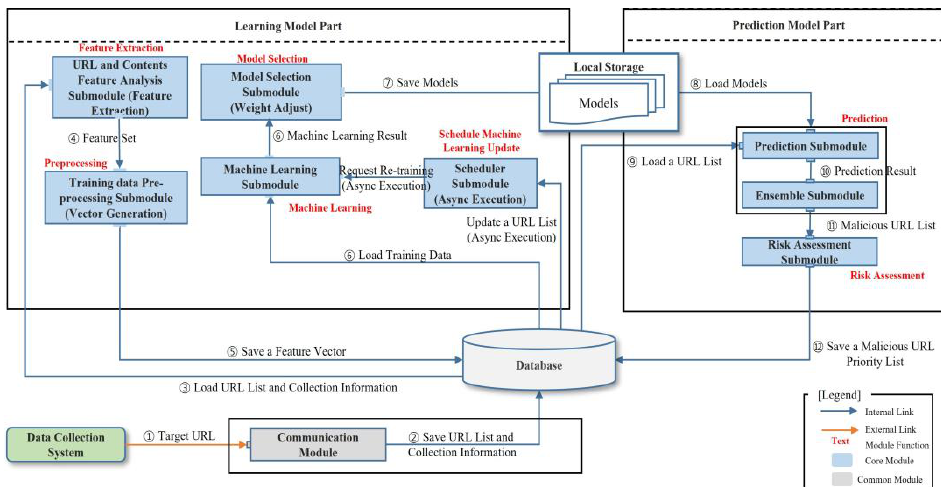
Figure 1. Malicious Code Distribution Automation Prediction System Architecture.